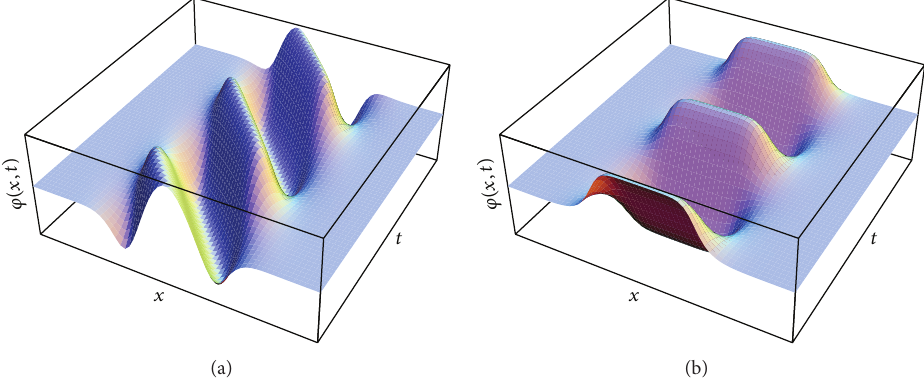
Figure 3: Typical profile of the flat-top oscillon. The left-hand figure corresponds to the case with Lorentz breaking symmetry and the right- hand figure to the one with Lorentz